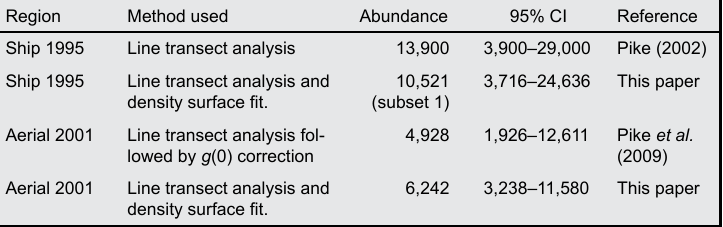
Table 5 . Comparison of abundance estimates from this paper with estimates obtained us- ing alternative methods.